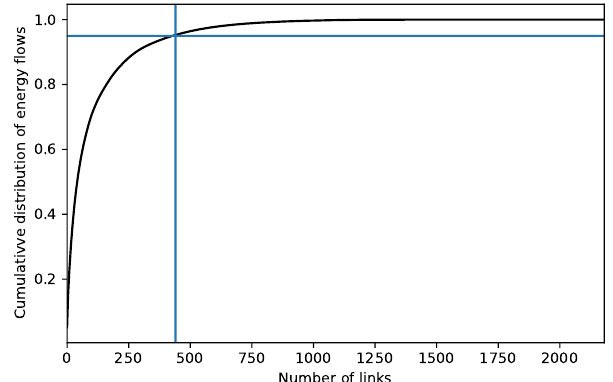
Figure 4. The cumulative distribution for the total fossil fuels trade in 2018.